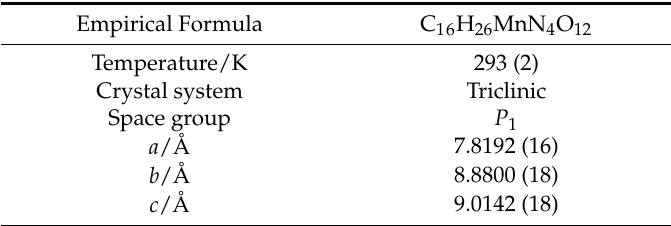
Table 3. Summary of crystal result for sodium complex.